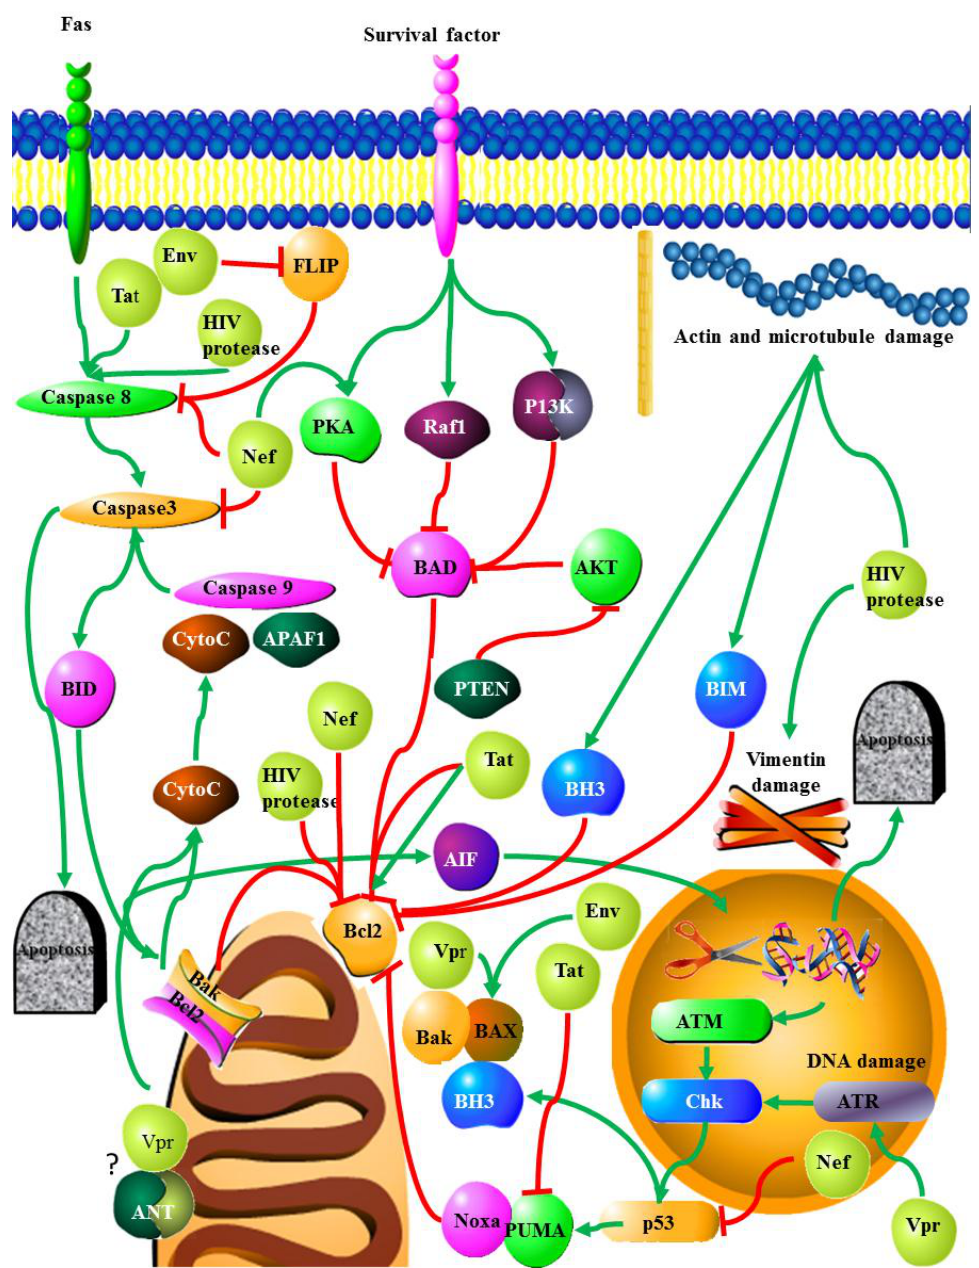
proteins [30]. Treatment of HIV infected cells with Anti-Fas antibodies did not completely block apoptosis, which points to the involvement of multiple death pathways [22]. Figure 1. The involvement of HIV proteins in intrinsic apoptotic pathways: The viral proteins are marked in yellow. Bcl-2 is a central molecule in these mitochondrial-mediated cell death pathways. This protein is a target of Tat, Nef and HIV protease. Depending on the pathway activated the virus either shifts the balance of pro-apoptotic Bcl-2 family proteins to anti-apoptotic counterparts or vice versa. HIV proteins also affect the activation of caspases, and control their inhibitors as well, thereby, influencing the p53 signaling